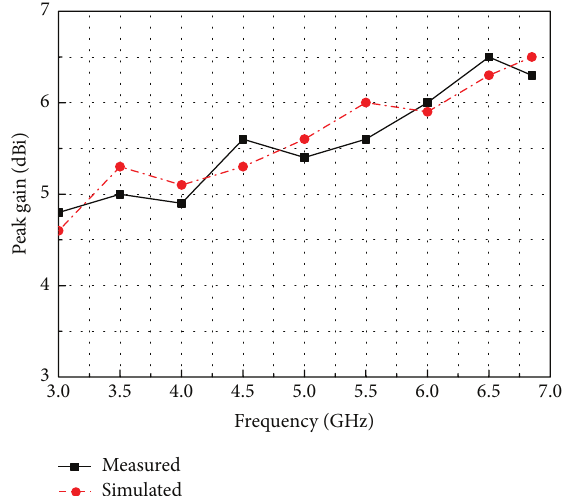
Figure 12: Measured and simulated peak gain of the proposed DRA.